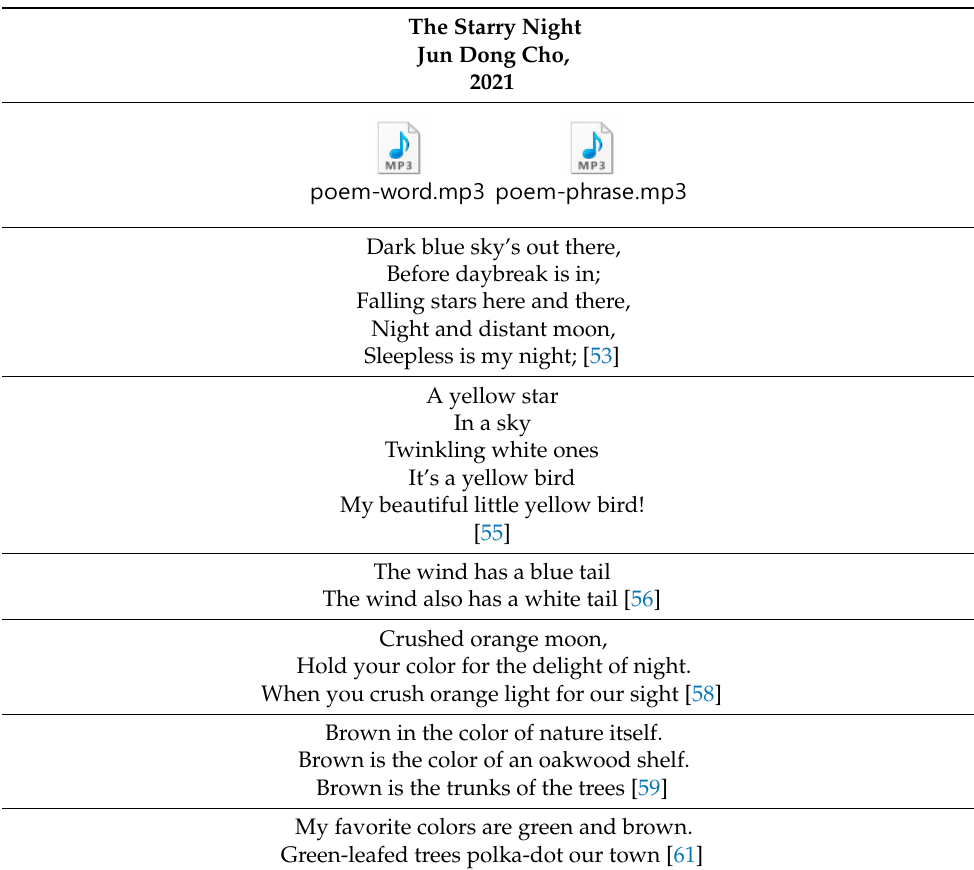
Table 9. Poetry for representing colors in Van Gogh’s “The Starry Night” (the sound files developed in this research are provided separately as a Supplemental Material).